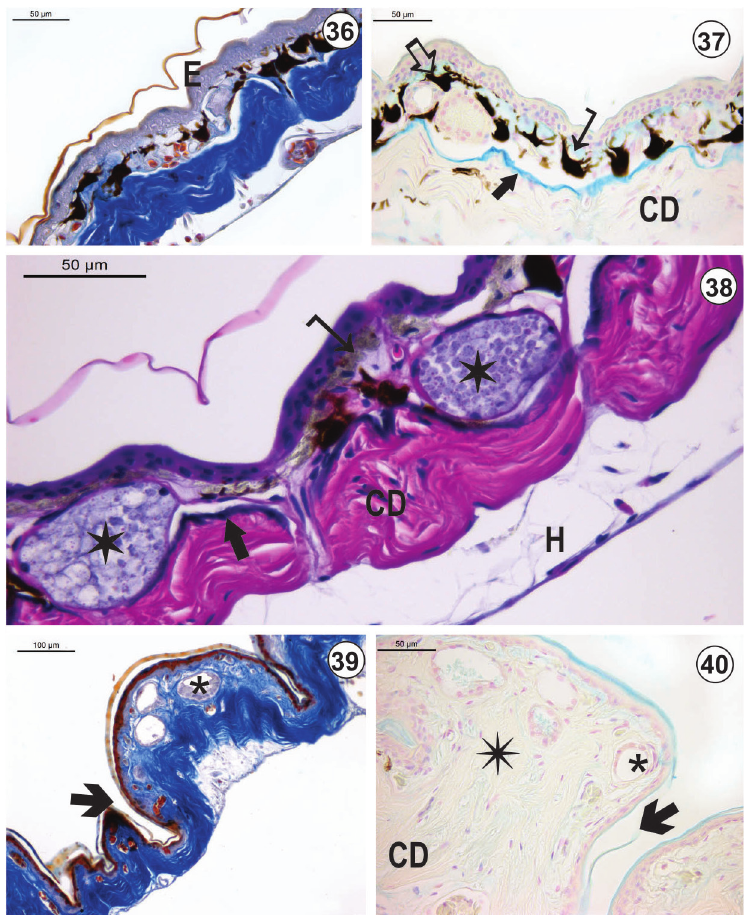
Figures 36–40. Light micrograph of the integument of S. similis : (36) Dorsal region (Mallory´s trichrome staining); (37) Dorsal region (AB-method); (38) Ventrolateral region (HE-staining); (39) Ventral region (Mallory´s trichrome staining); (40) Ventral region (AB-method). Melanophores ( _ ) and iridophores ( → ) organized as chromatophore units occur in both dorsal and ventrolateral integument. Iridophores exhibit alcianophilic reaction. Note serous glands ( Ø ) and apocrine glands with granular content ( ¬ ) in the spongious dermis. In the ventral region, cutaneous elevations ( ¬ ) are separated by prominent grooves ( Ú ). The EK-layer ( Æ ) occur in the dorsal integument but not in the ventral integument. Moreover, the epidermis (E) of the ventral region is more developed than other integument regions. E = epidermis; CD = compact dermis; H =